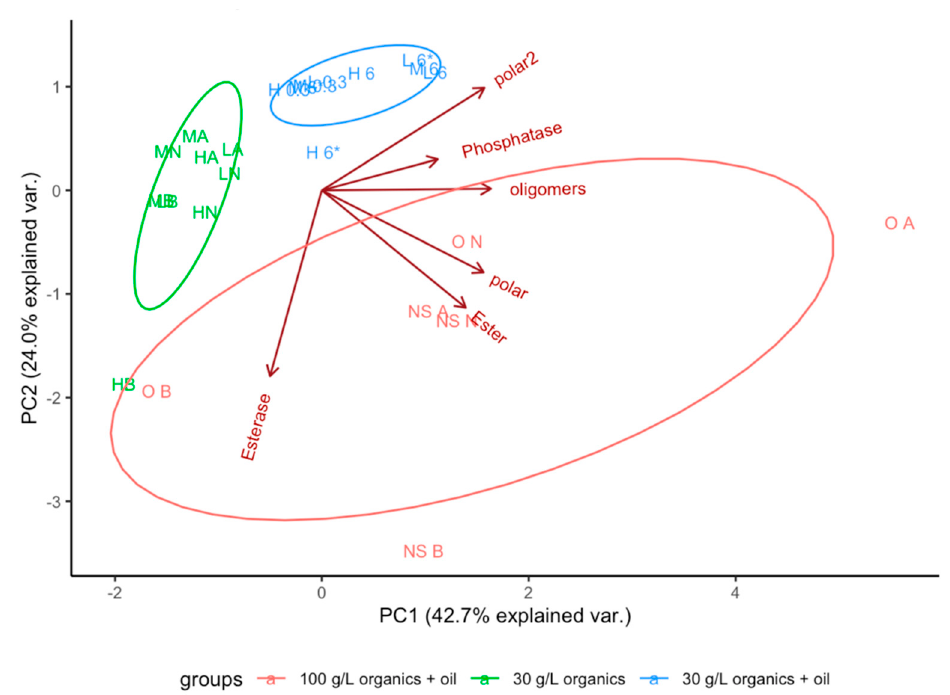
Figure 4. PCA of evolved soups grouped by starting organic composition. Samples containing 100 g/L organics including mineral oil are in red, 30 g/L organics not including mineral oil are in green, and 30 g/L including mineral oil are in blue.